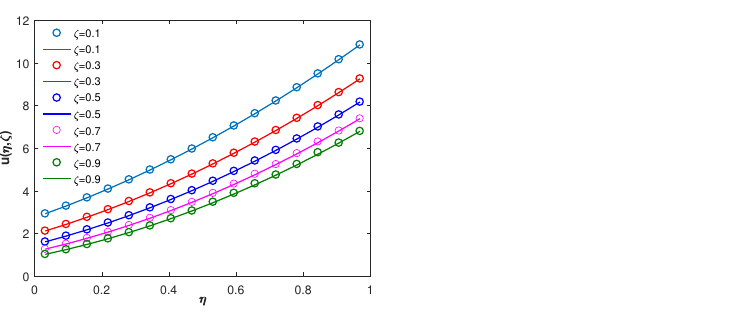
Figure 4. Comparison of analytic and FWM solutions of Example 2 at k = 3, M = 4 for different ζ